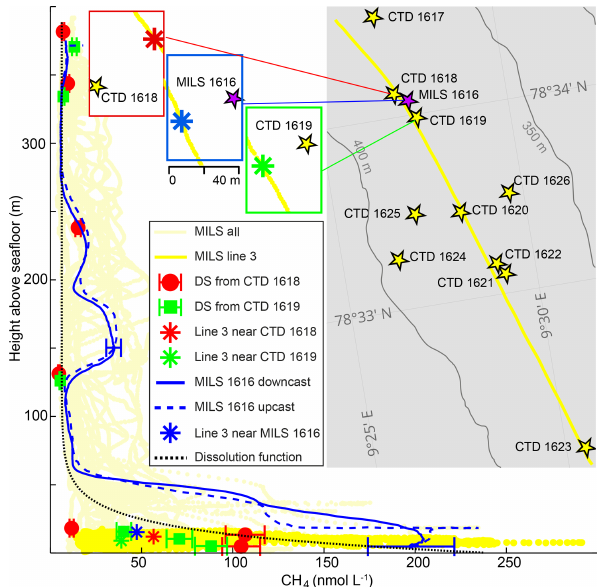
Figure 4. High-resolution CH 4 concentrations and discrete sam- ples. Light-yellow lines show CH 4 concentrations acquired with the MILS during the entire survey and the bright yellow derives from line 3 at ∼ 15ma.s.f. only. Solid and dashed blue lines represent continuous down- and upward profiles acquired at station 1616 after correction for instrument response time. The blue error bars indicate the instrument uncertainty of 12%. Discrete sample data are shown as red dots (CTD 1618) and green squares (CTD 1619) with error bars that indicate the discrete sampling or headspace GC method uncertainty of 4%. The asterisks indicate MILS data points from the towing along line 3, closest to the vertical cast 1616 (blue), to CTD 1618 (red) and CTD 1619 (green). The dotted black line indi- cates the exponential dissolution function described in the text. The inset map shows the locations of the CTDs with discrete sampling (station nos. 1617–1623) (yellow stars) as well as line 3, which is indicated with a yellow line. The blue rectangle shows the location of the vertical MILS profile from station 1616 (purple star) and the data point from line 3, which is closest to the deepest location of the vertical cast (blue asterisk). The green rectangle shows the location of CTD 1619 and the closest point on line 3 (green asterisk), while the red rectangle shows the location of CTD 1618 and the corre- sponding point on line 3 (red asterisk). Bathymetric contours were drawn from the IBCAO dataset (Jakobsson et al.,